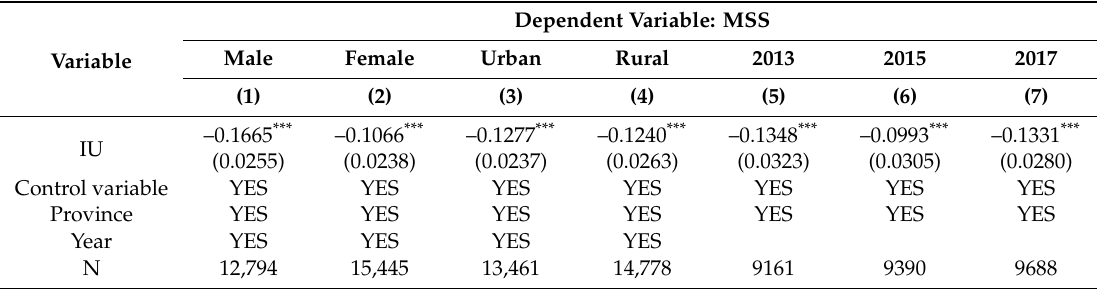
Table 6. Internet use and medical service satisfaction: Subdivided sample analysis (by gender, urban-rural and